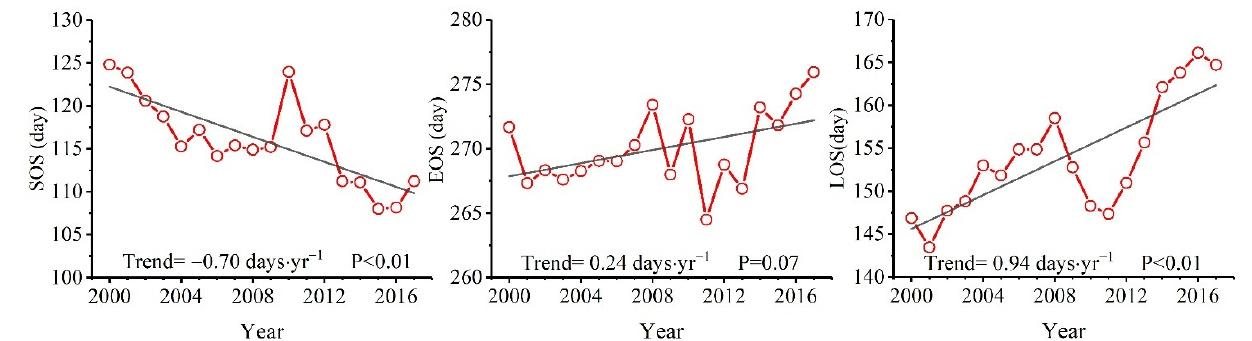
Figure 2. The overall trends in vegetation phenology in the Dongting Lake basin during 2000–2017.